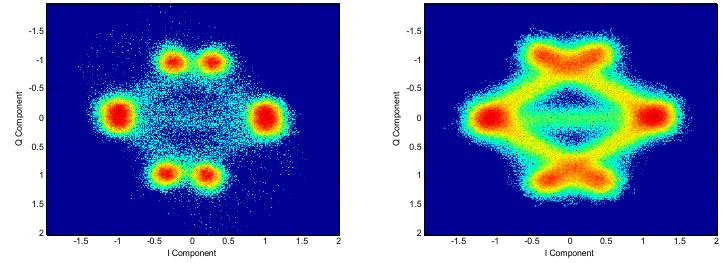
Figure 12. Comparison of QZSS L1 frequency compatible signal and GPS signal constellation.